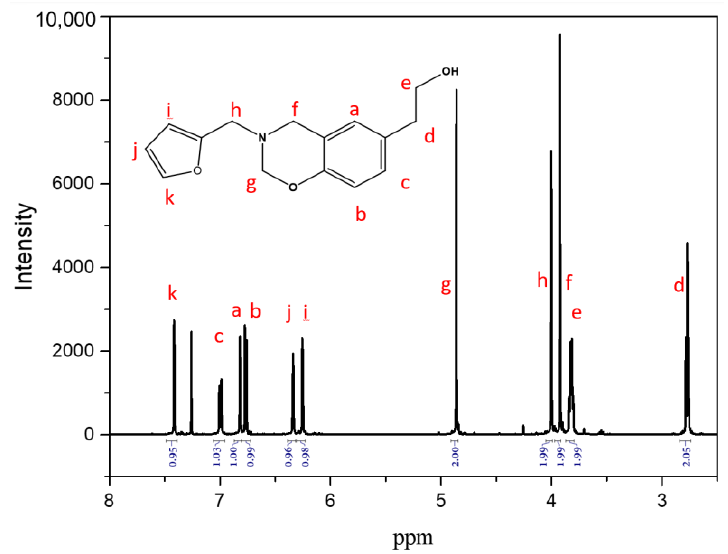
Figure 2. 1 H NMR spectrum of T–Fa in deuterated chloroform (CDCl 3) .